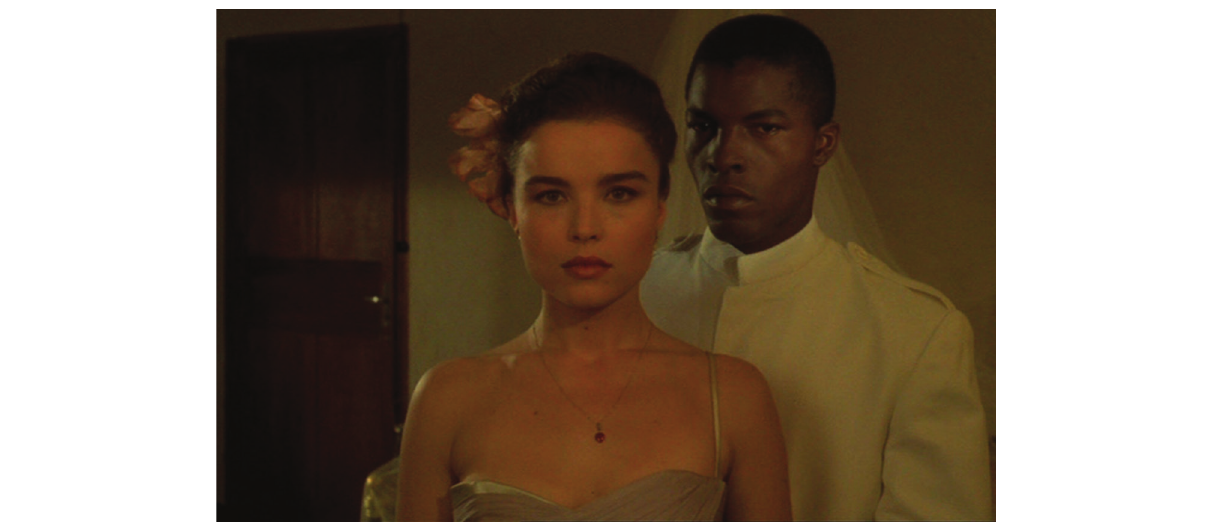
Figure 1. Still from Chocolat (Claire Denis,